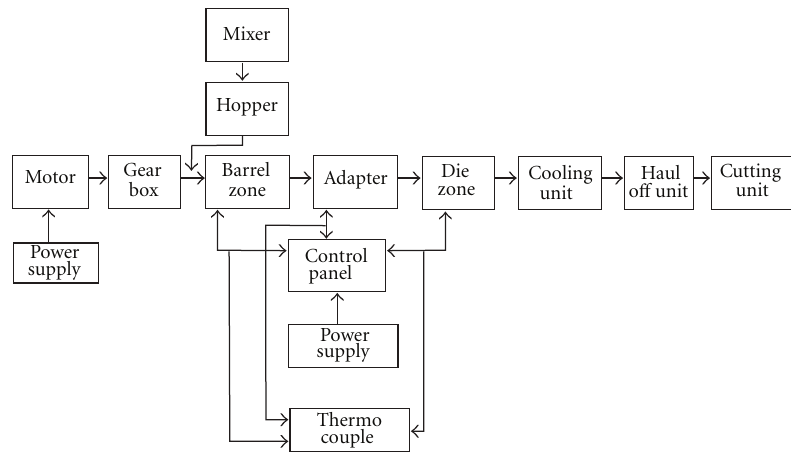
Figure 1: Overall structure of the plastic extrusion system.